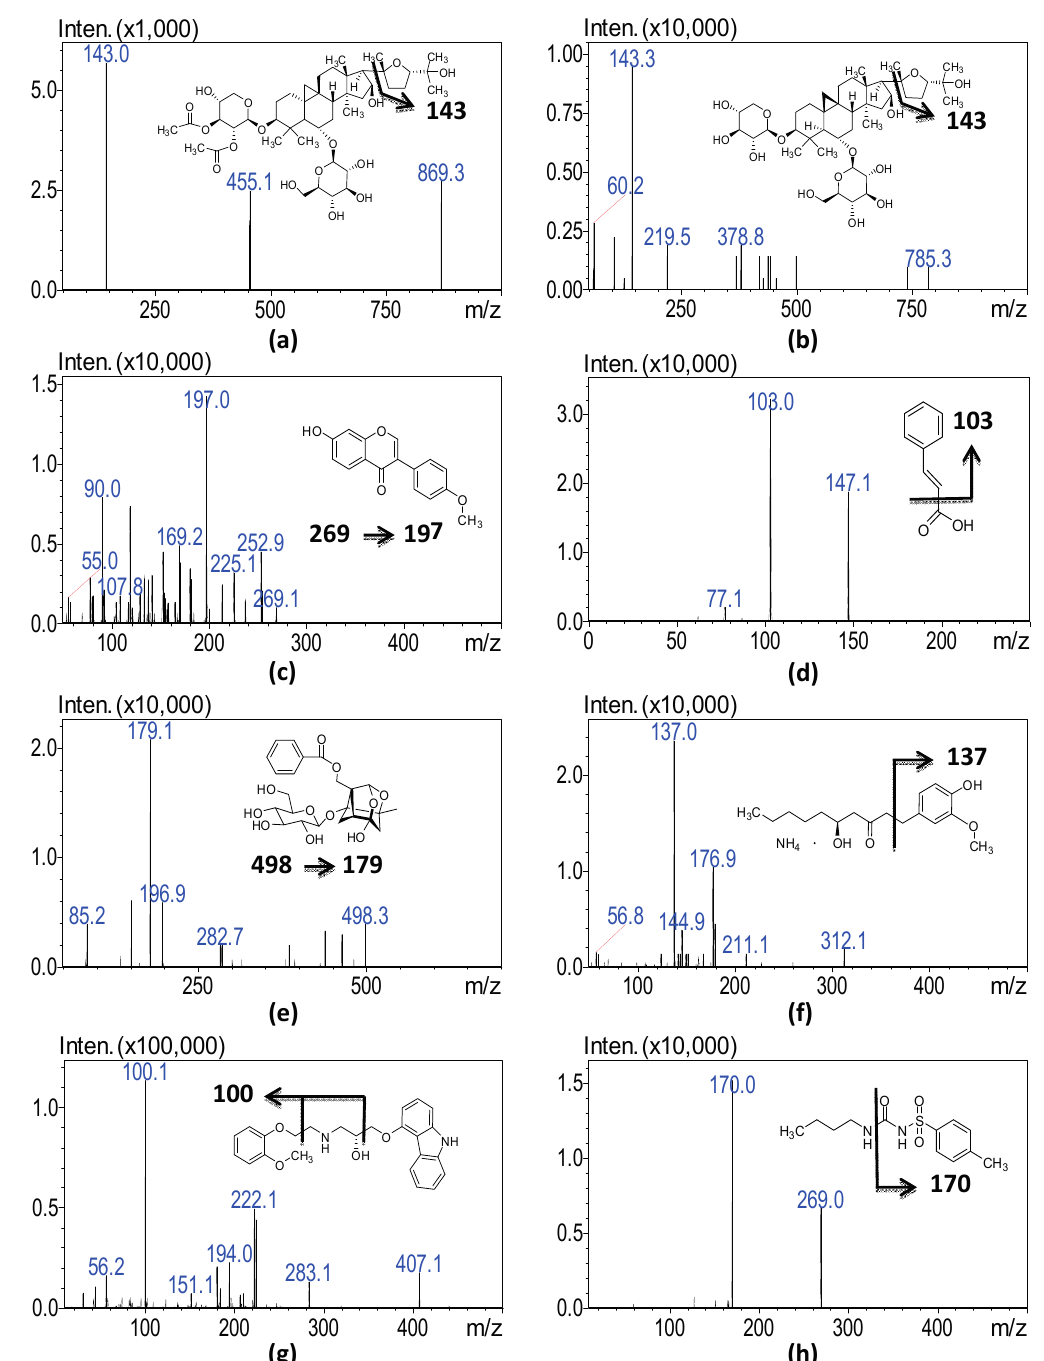
Figure 1. The mass spectra and structures of six active components in HGW and two internals: ( a ) astragaloside I; ( b ) astragaloside IV; ( c ) formononetin; ( d ) cinnamic acid; ( e ) paeoniflorin; ( f ) gingerol; ( g ) carvedilol and ( h ) tolbutamide. All of the fragment ions could be detected in our study, and the product ion at m/z 137 was selected as having good sensitivity. The detection of cinnamic acid was performed in negative mode, and the peak at m/z 103 after losing a carboxylic acid moiety was obtained. The internal standards (carvedilol and tolbutamide) were analyzed in positive and negative ESI modes, respectively. Detailed mass spectrometry conditions are summarized in Table